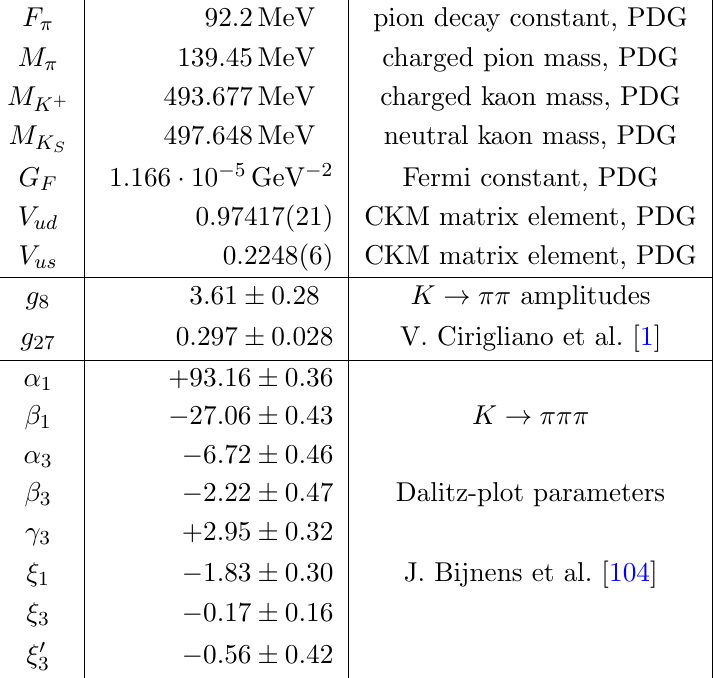
Table 3 . Numerical values used for the various input parameters. The (cid:12)rst seven entries are taken from ref. [58], and the values of the constants g 8 and g 27 come from ref. [1]. The (cid:12)t of ref. [104] provides the values for the K (cid:25)(cid:25)(cid:25) Dalitz-plot parameters (cid:11) 1 ; : : : (cid:24) 0 , which are given in units 3 ! of 10 (cid:0) 8